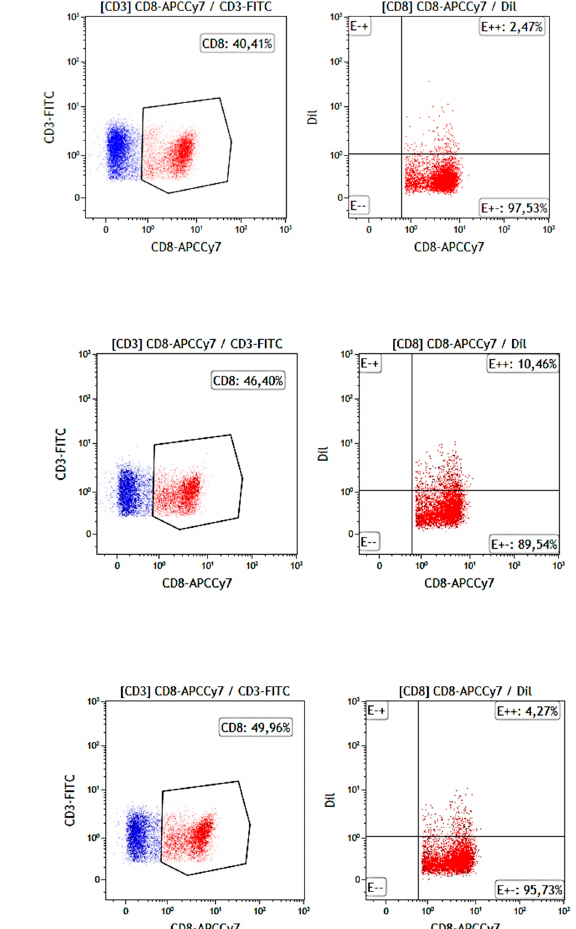
Figure 5. Trogocytosis analysis carried out with CD8 + T lymphocytes recovered after cross-priming co-cultures. FACS analysis of PBLs recovered, as described in Figure 4, and co-cultivated with N-peptides treated, CM-Dil-labeled MCF-7 cells. Gating strategy: co-cultures labeled with both FITC- conjugated anti-CD3 and APCCy7-conjugated anti-CD8 mAbs were selected for CD3 expression (for PBL identification), and then the CD8 + cells were identified within CD3 + cell populations. CD8- labeled cells were finally scored for the CM-Dil-specific fluorescence. Quadrants were set based on the background fluorescence as detected after cell labeling with relevant IgG isotypes. Data are representative of two independent experiments carried out with cells from different HLA-A02 healthy donors.